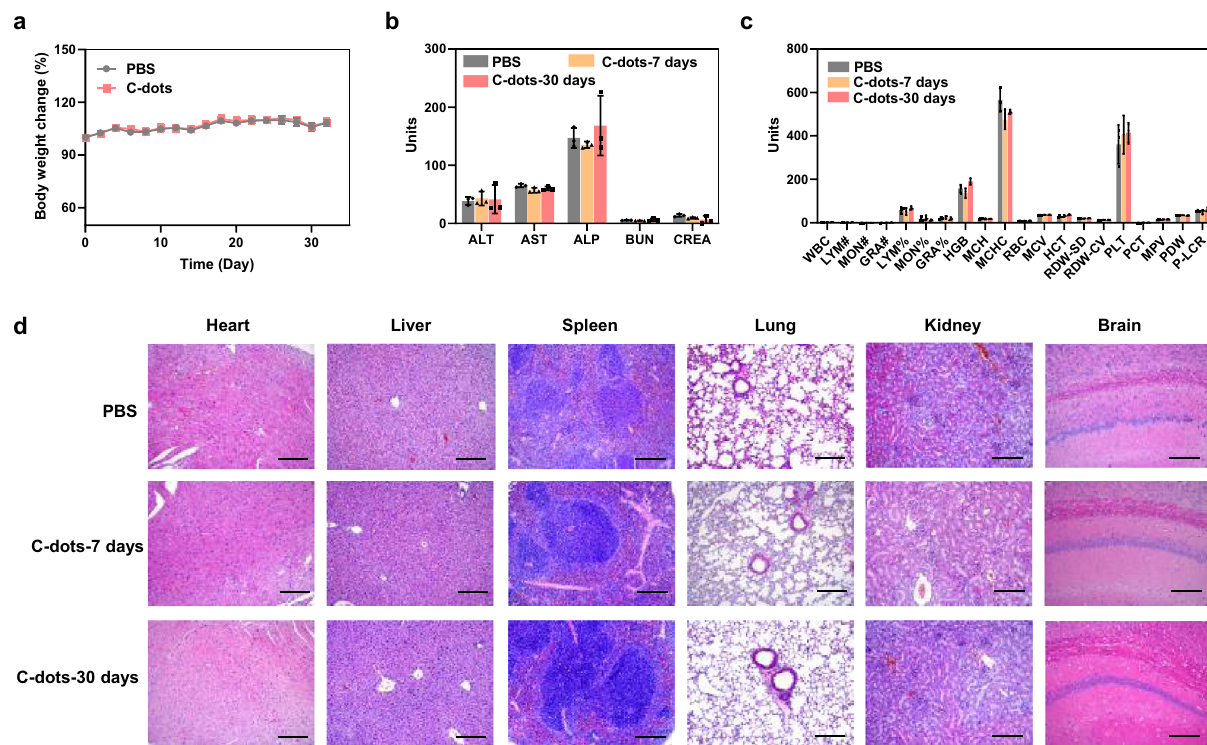
Fig.7|InvivobiosafetyanalysisofC-dotSODnanozymes.a Bodyweightchange in healthy mice after treatment with PBS and C-dot SOD nanozymes, respectively ( n =4 mice). b Blood biochemical analysisand c routine blood test ofhealthy mice at7 days post-injection of C-dot nanozymes and 30 days post-injection of PBSand C-dot SOD nanozymes, respectively (n=3 mice). The units of different parameters